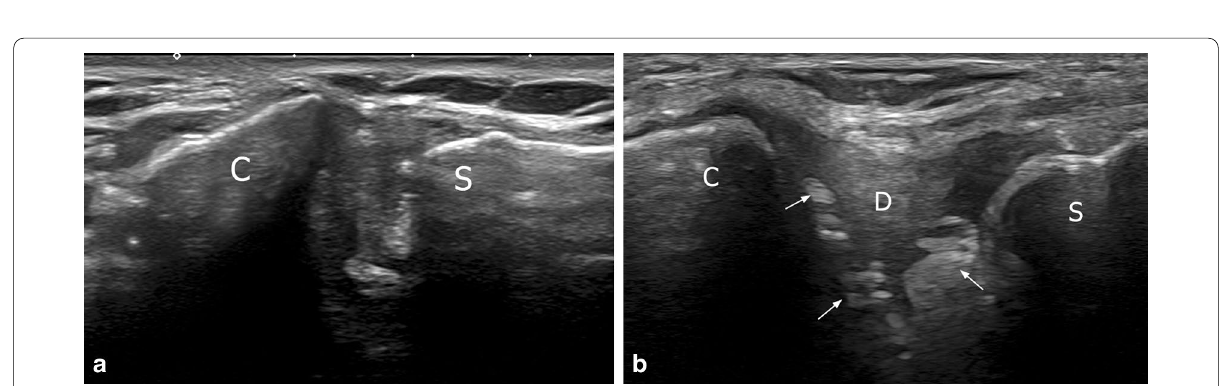
Fig. 5 Intra-articular gas (arrows) preventing ( a ) or allowing ( b ) analysis of the intra-articular disc (upward and outward oblique transverse plane). C: clavicle, S: sternum